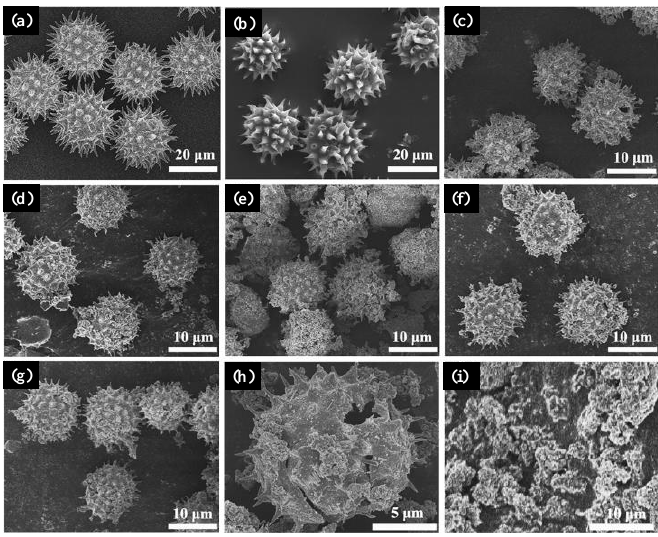
Figure 11. Micrograph of sunflower pollen ( a ), ZrO 2 -doped TiO 2 spinous hollow sample before calcination ( b ), 4.6% doped TiO 2 sample ( c ), 8.8% doped TiO 2 sample ( d ), 12.6% doped TiO 2 sample ( e ), 18.2% doped TiO 2 sample ( f ), calcinated sample presented in a smaller size due to the removal of the pollen template ( g ), hollow microsphere ( h ), and TiO 2 samples synthesized without templates ( i ). Figure adapted with permission from [167] Copyright 2018 Elsevier.